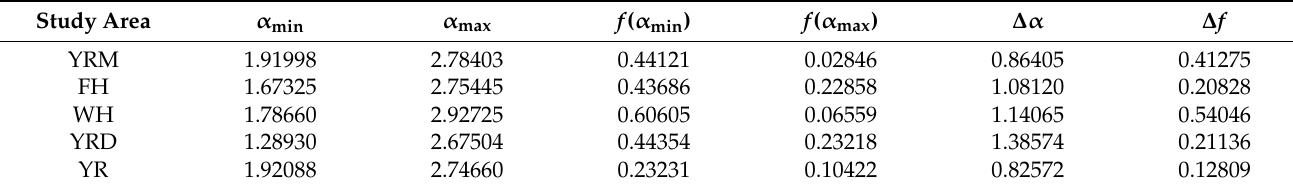
Figure 7. The multifractal spectra of ( a ) The Yellow River Mainstream Basin (YRM), ( b ) The Fenhe River Basin (FH), ( c ) The Weihe River Basin (WH), ( d ) The Yellow River Downstream Basin (YRD), and ( e ) The Yellow River Basin (YR). Table 1. Multifractal characteristic parameters of the study areas.